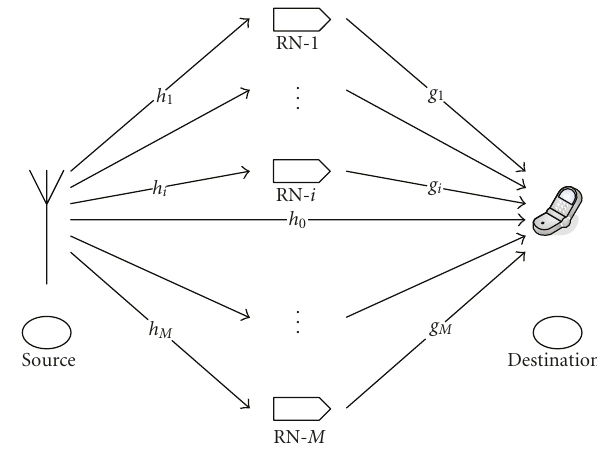
Figure 2: Cooperative relaying communication in a single